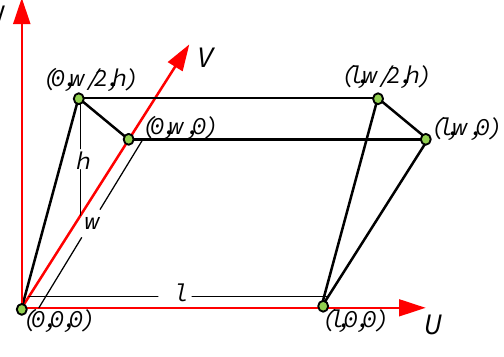
Figure 10. The model coordinates of the gabled primitive’s vertices calculated by shape